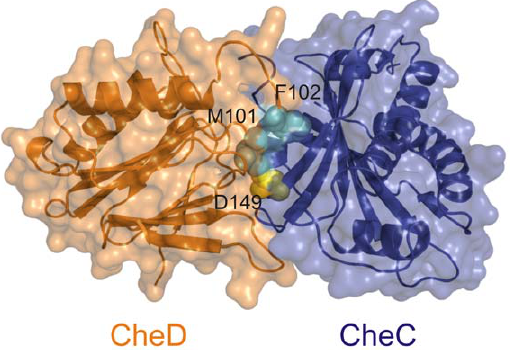
Figure 2. A CheC/CheD structural model based on the T. maritima crystal structure (PDB ID 2F9Z) shows residues at the binding interface [ 21 ] . Residues M101 and F102 on CheD are highlighted in cyan, and residue D149 on CheC is highlighted in yellow.